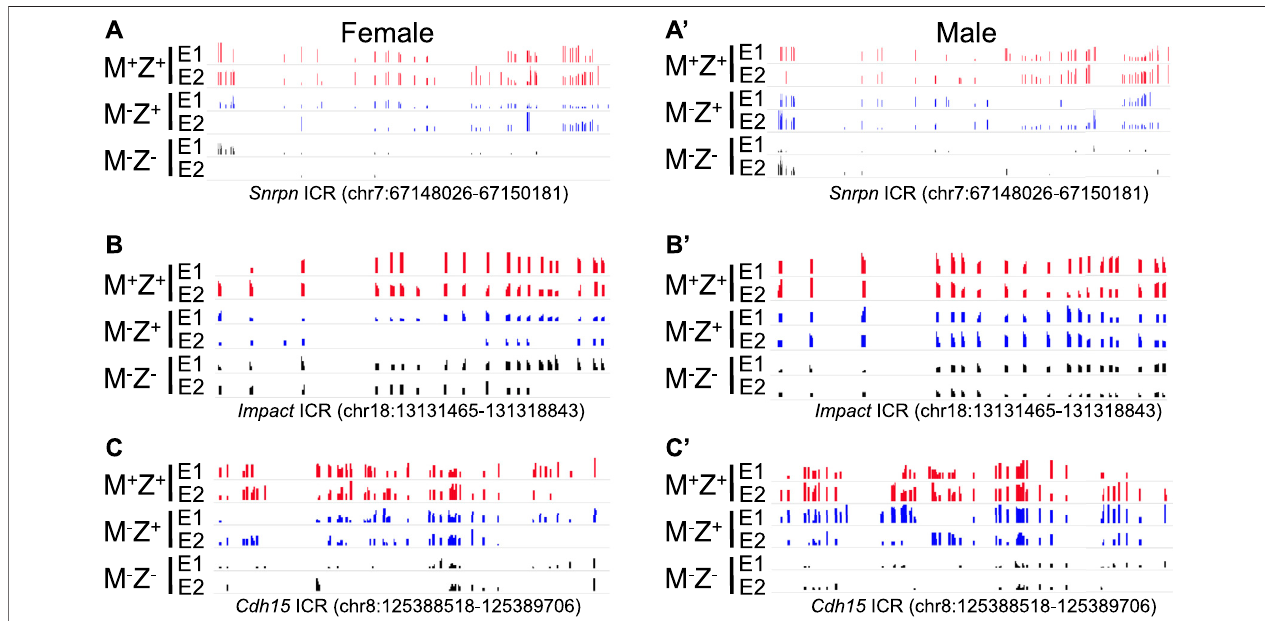
FIGURE6| DNAmethylationwaspartiallylostatthe Snrpn , Impact ,and Cdh15 ICRsinthefemaleormaleembryoslackingjustmaternal Zfp57 onthemethylation IGV plot. After WGBS analysis of the genomic DNA samples isolated from Zfp57 +/+ (M + Z + ), Zfp57 − /+ (M − Z + ), and Zfp57 − / − (M − Z - ) hybrid 129/DBA embryos, the methylation IGV plots with the scale of 0 – 1 are shown for the Snrpn , Impact , and Cdh15 ICRs in two female embryos (E1 and E2) or two male embryos (E1 and E2) for each of the M + Z + , M − Z + , and M − Z - genotypes. DNA methylation imprint was partially lost at these three imprinted regions in the M − Z + embryos, although more severe loss of DNA methylation was observed in the M − Z - embryos. (A,A ’ ) Methylation IGV plot of the Snrpn ICR (mm9, chr7:67,148,026 – 67,150,181) in the female (A) or male (A ’ ) embryos. (B,B ’ ) Methylation IGV plot of the Impact ICR (mm9, chr18: 13,131,465 – 1,31,318,843) in the female (B) or male (B ’ ) embryos. (C,C ’ ) Methylation IGV plot of the Cdh15 ICR (mm9, chr8:125,388,518 – 125,389,706) in the female (C) or male (C ’ ) embryos.